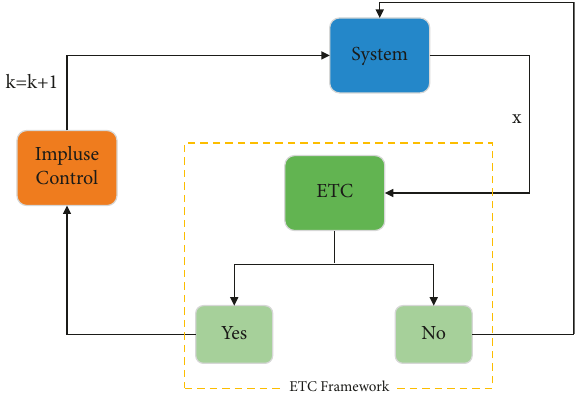
Figure 1: The block diagram for